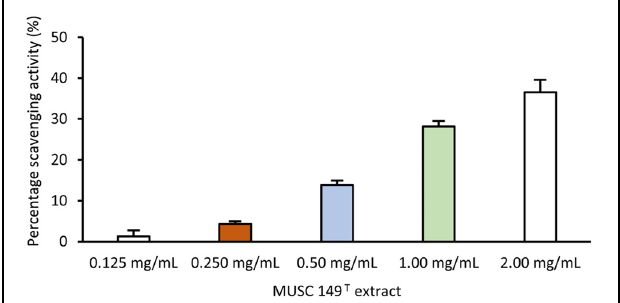
FIGURE 4 | Antioxidant activity of MUSC 149 T methanolic extract. Antioxidant activity of MUSC 149 T was evaluated at different concentration and values are SEM of four